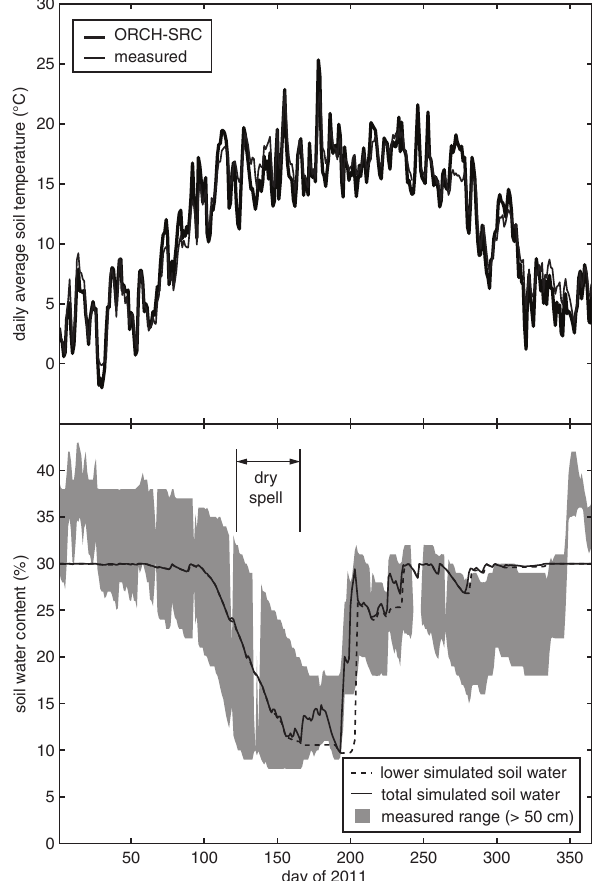
Figure 6. A comparison of modelled and measured soil state vari- ables for 2011 at the POPFULL site. (a) shows the daily average soil temperature simulated (thick) and measured (thin). (b) shows the soil water content. The grey area represents the measured range of soil water content values for the top 50cm of the soil. The dotted line is the soil water content of the lower soil water compartment of the model, and the solid line is the total soil water content of the upper and lower soil water